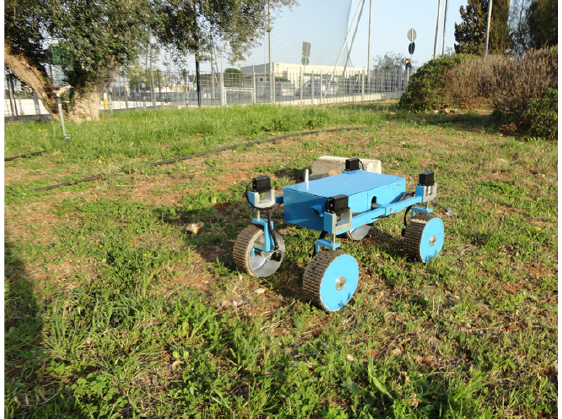
Figure 6. The test field and the rover